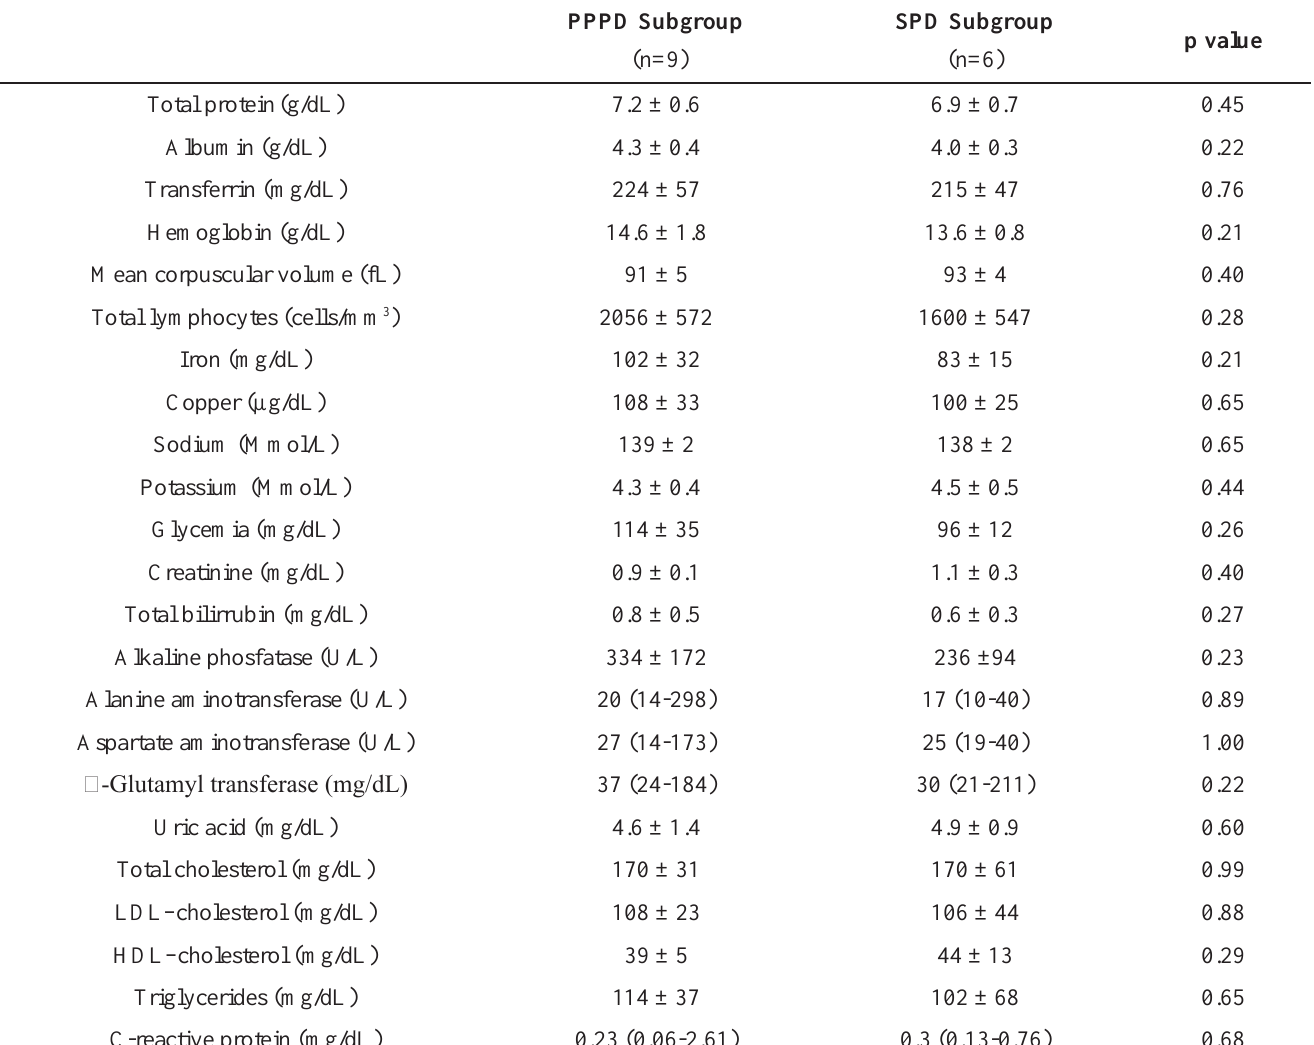
TABLE 3 - Clinical and nutritional laboratory data in the PPPD and SPD